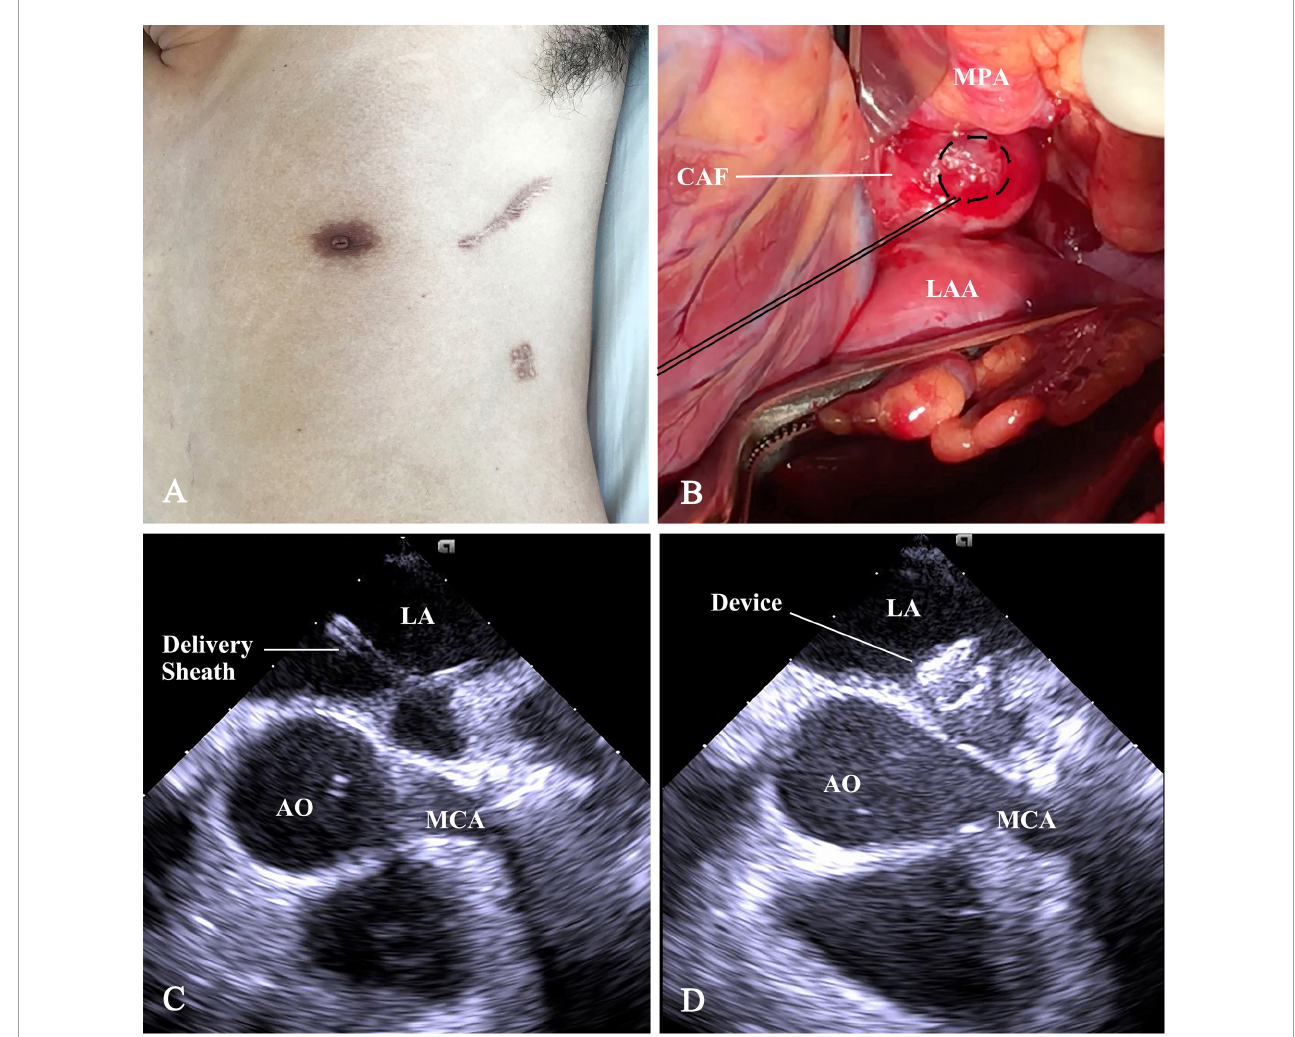
FIGURE2 Schematic presentation of percoronary device closure of CAF. (A) The subaxillary incision. (B) The distal straight section of CAF was exposed between the main pulmonary artery (MPA), root of AO, and the LAA. A purse-string suture was placed on it. (C) Following a puncture in purse-string, a flexible guidewire was advanced into LA. Then, a 6F short delivery sheath was fed over the wire into the LA. (D) The device was deployed and positioned at the drainage orifice of the CAF. CAF, coronary artery fistula; AO, ascending aorta; LAA, left atrial appendage; LA, left atrium; MPA, main pulmonary artery; MCA, main coronary